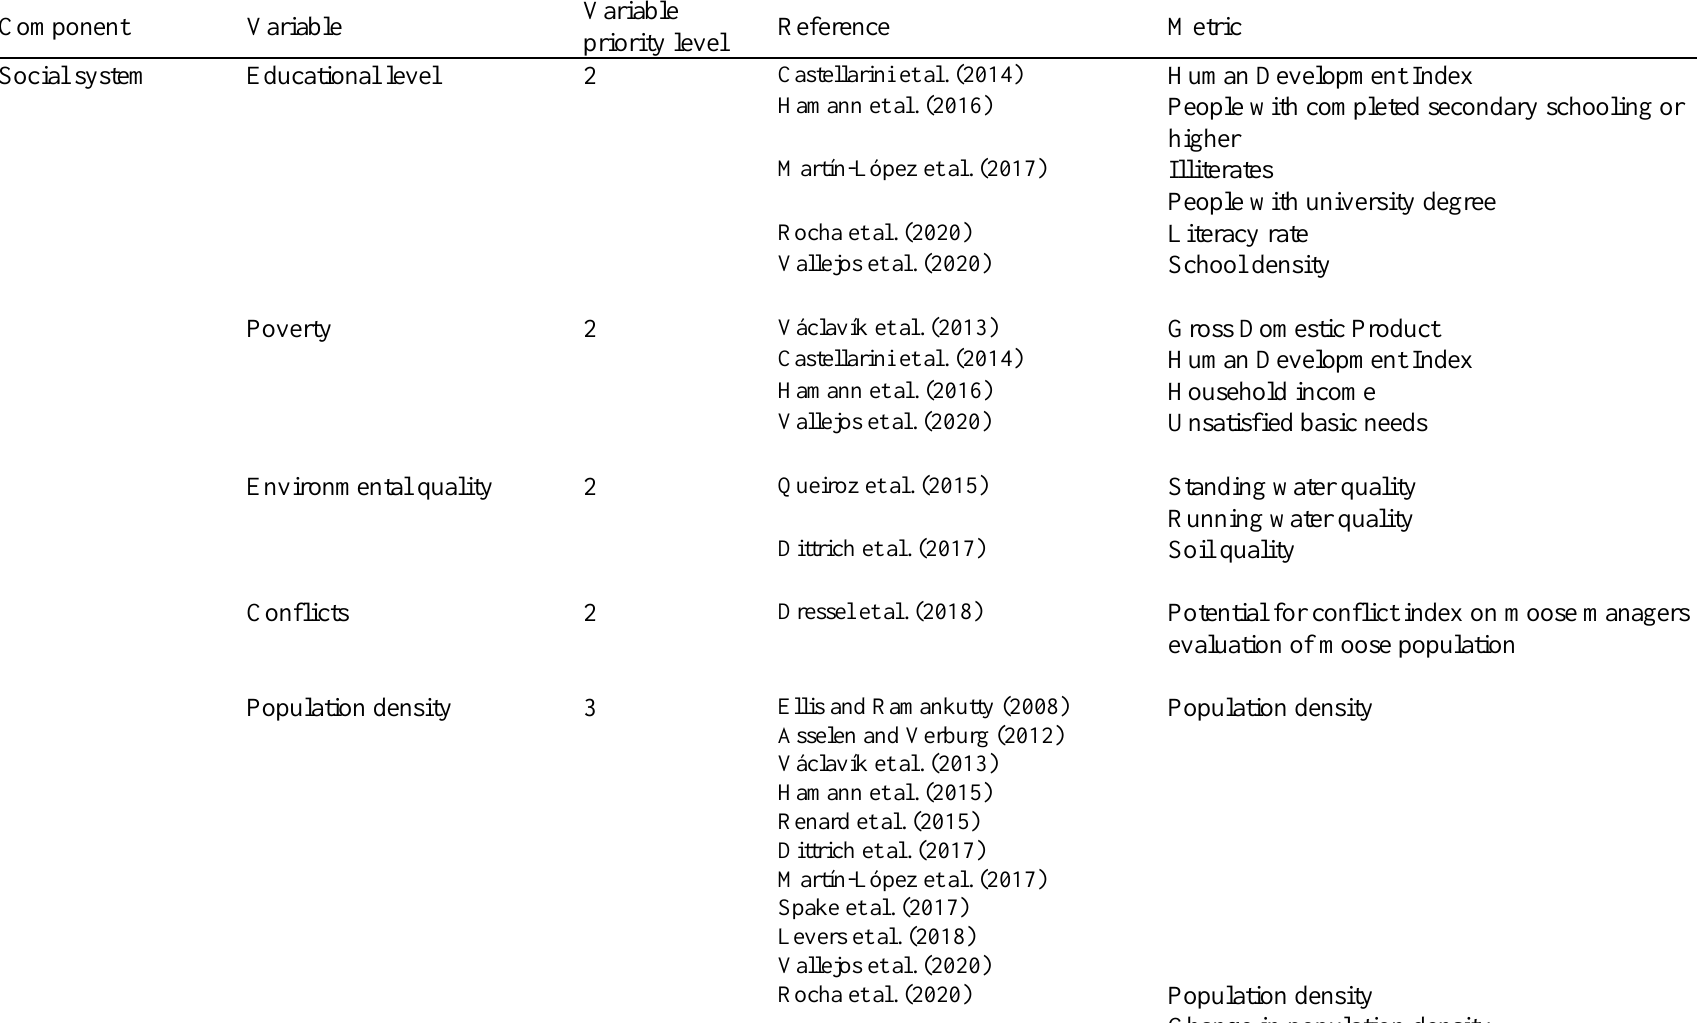
Table A5.3. Examples of studies that have used prioritized variables to map SES distribution and dynamics. The specific metrics used to map SESs associated with the priority variables identified in our study are listed. Nonpriority variables (those that obtained the lowest scores in the survey) and additional variables not included in our list are also matched to the metrics used to map